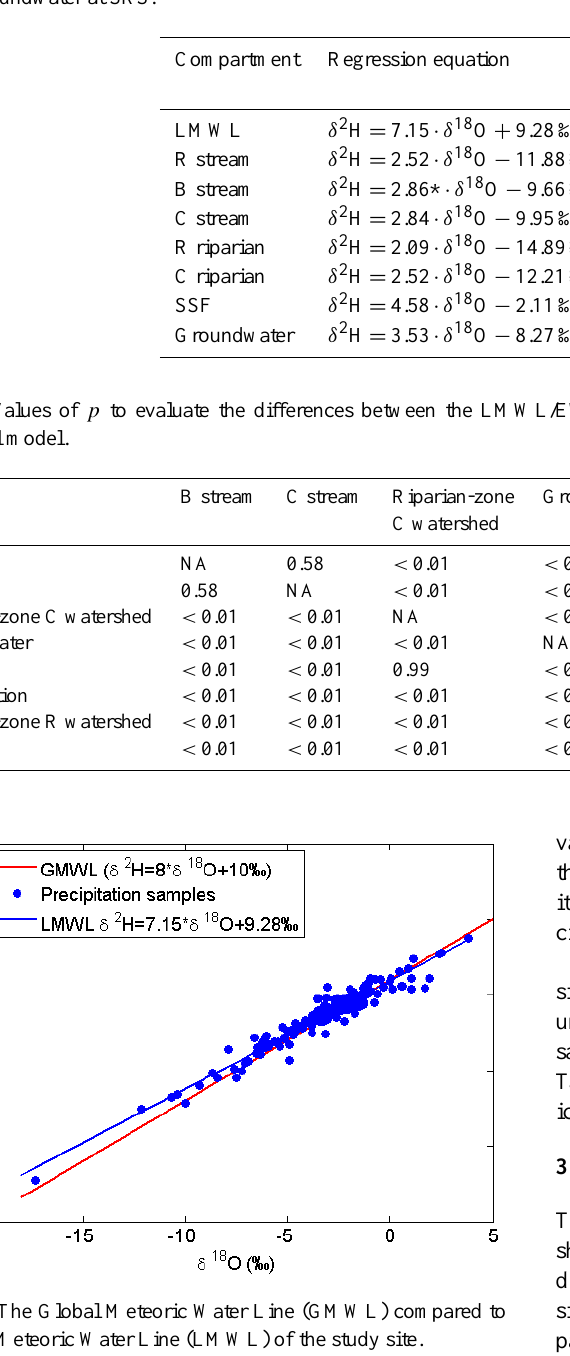
Table 1. Summary of the MWLs/EWLs of the different hydrological compartments, including their regression equation, the coefficient of determination ( R 2 ) and p value of the regression, and the number of samples available for the regression. R, B, and C stand for the three watersheds, stream indicates streamflow, riparian stands for the riparian groundwater, SSF for subsurface stormflow, and groundwater for the deeper groundwater at SRS.